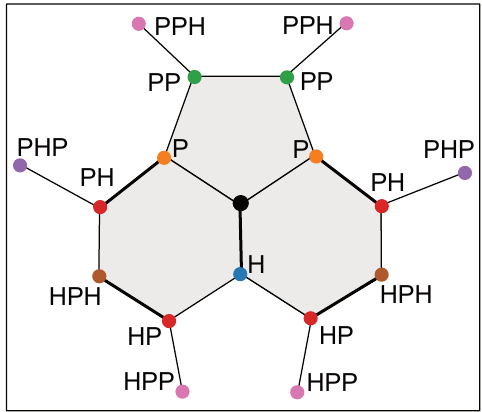
Figure 3: Neighbourhood of a given site (black circle) showing the various types of bonds (cf. Fig. 1).